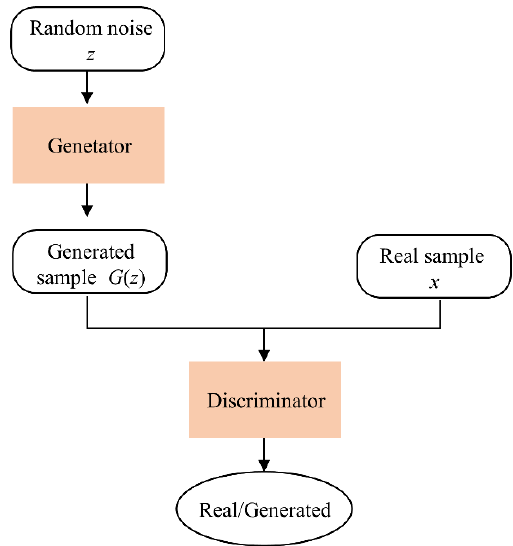
Figure 1. The structure of GANs.